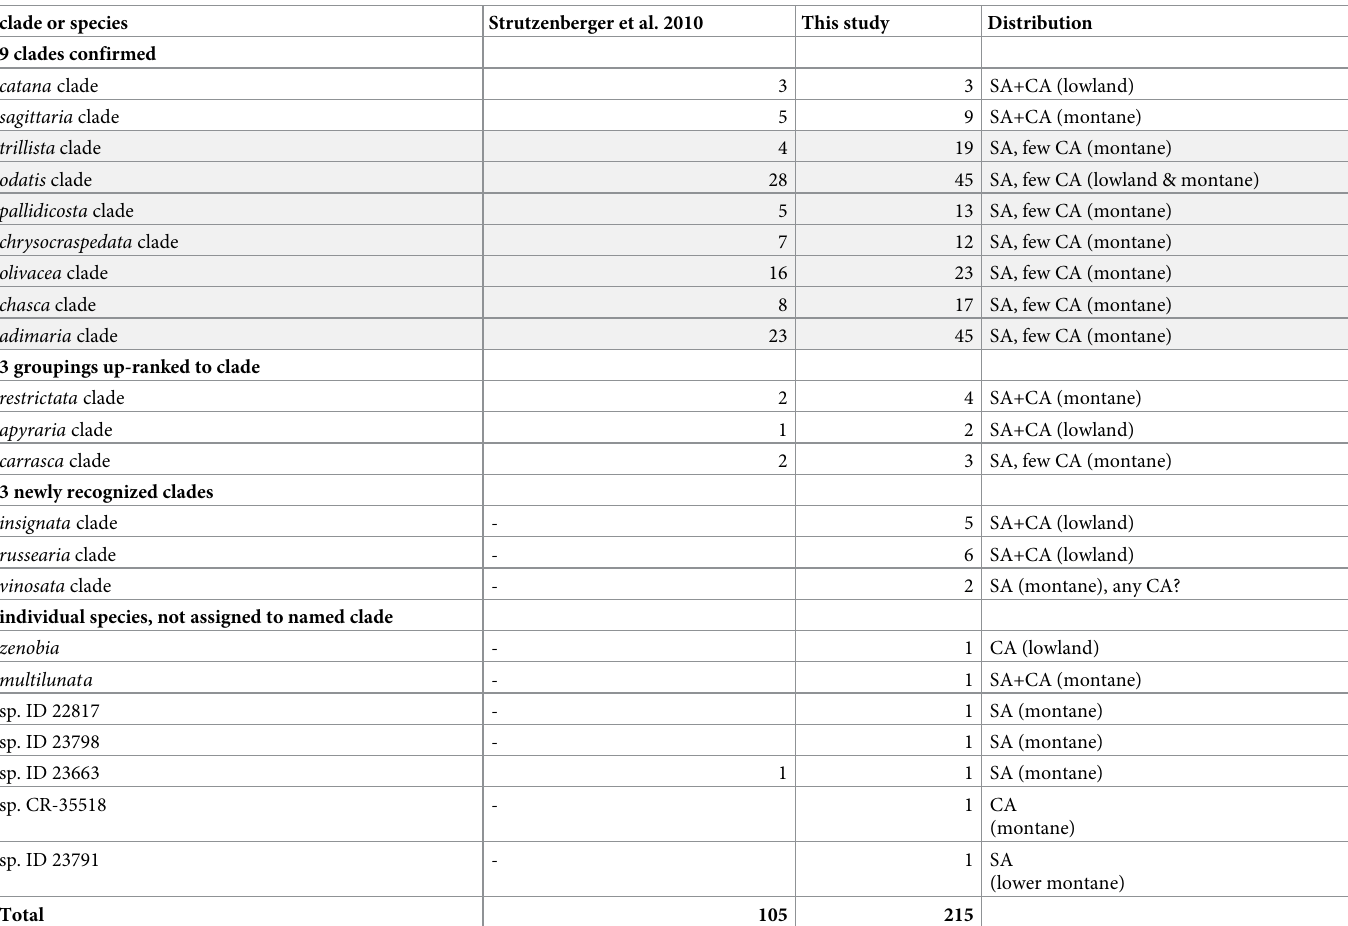
Table 1. Overview of clades recognized within Neotropical Eois moths. Numbers of species represented in [11] and in the current study are indicated as well as provi- sional distribution information. A named clade consists of a well-supported monophyletic group comprising at least two species. Shaded in grey: large clades ( > 10 species). SA: South America, CA: Central